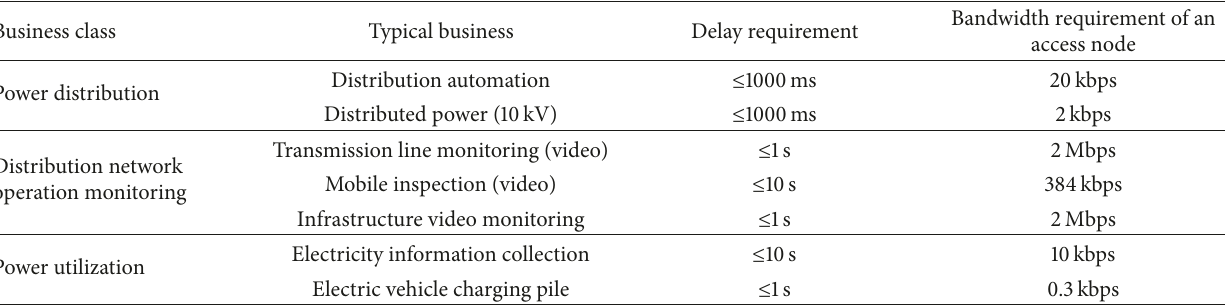
Table 1: The QoS requirement of